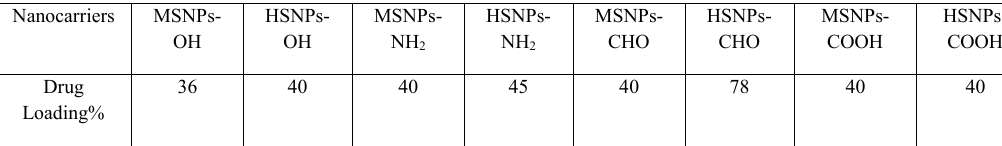
, (c) HSNPs-CHO, (d) HSNPs-COOH 2